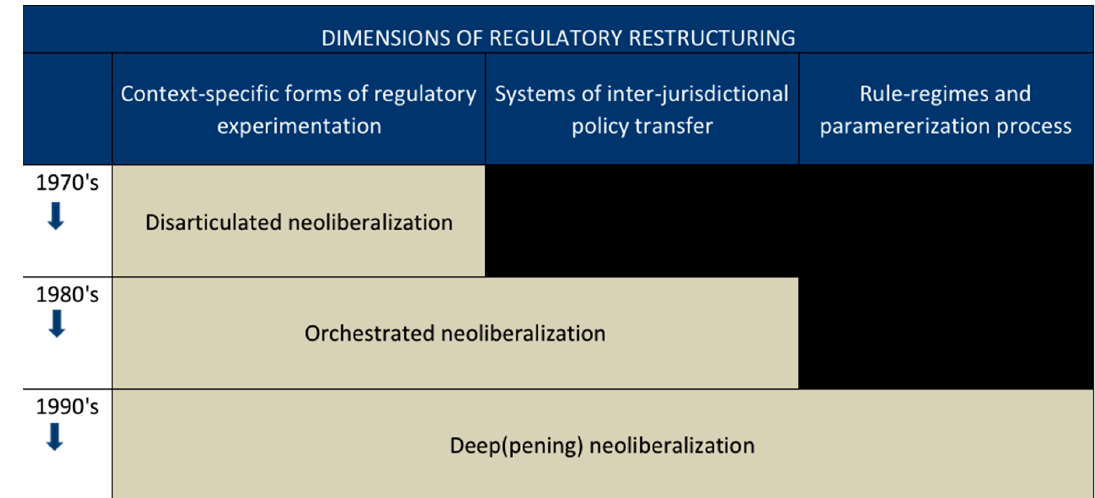
Figure 1. Dimensions of Regulatory Restructuring [7]